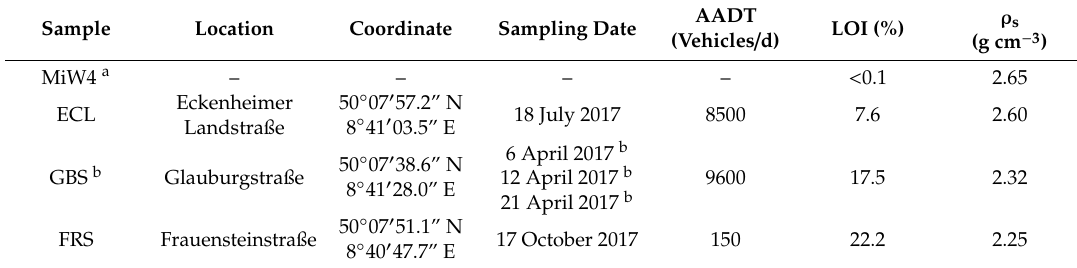
Table 1. Characteristics of sampling site and studied materials ( < 250 µ m), LOI (loss on ignition), and ρ s (particle density) were calculated after fractionation and recomposition, as described below.